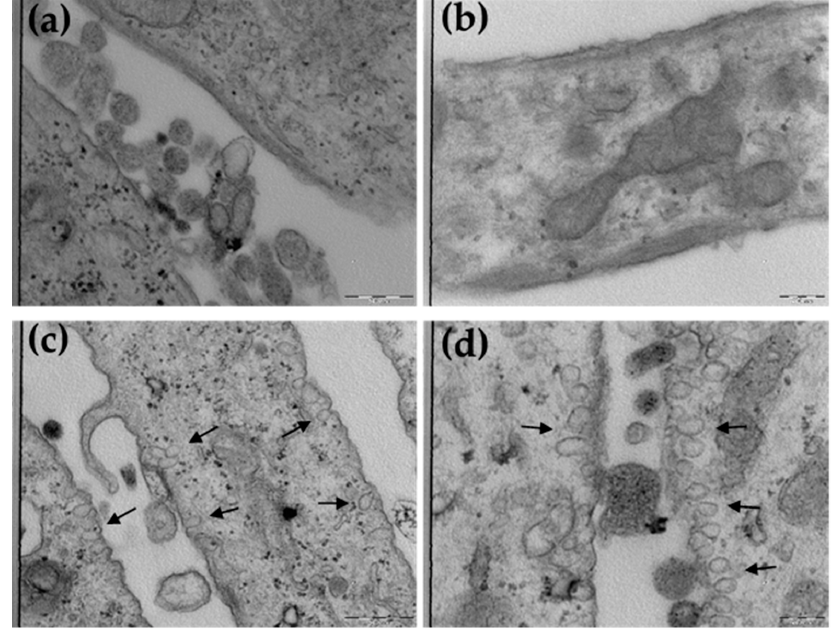
Figure 5. TEM images of control cells ( a , b ) and cells treated with ETHO 0.9 ( c , d ). Images of panels (a) and (c) refer to 31.5K magnification; images of panels (b) and (d) refer to 50K magnification. Arrows indicate the presence of ETHO 0.9 . Bar corresponds to 500 nm.